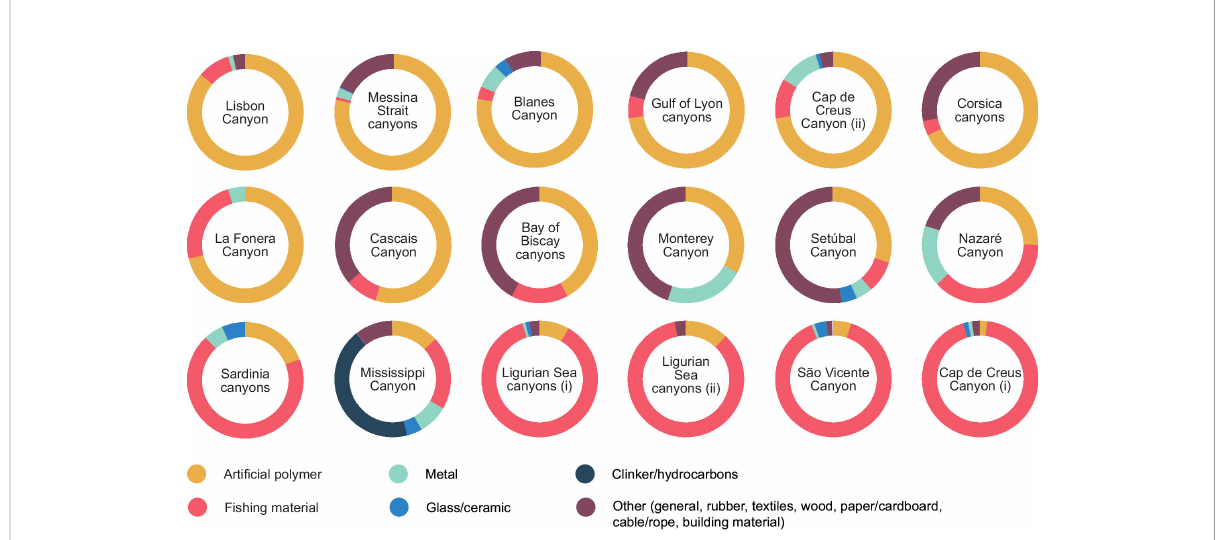
FIGURE 10 Low resolution litter composition in submarine canyons ordered by proportion of arti fi cial polymer, adapted from the standardized custom 12 broad categories in Figure 7, where ‘ Other ’ represents building material, cable/rope, paper/cardboard, textile, rubber, wood and general/ miscellaneous, for brevity and clarity. Ligurian Sea canyons were detailed in two separate studies targeting different canyons within that broad geographical area. Cap de Creus studies were kept separate as they display distinctly different litter typologies for the same